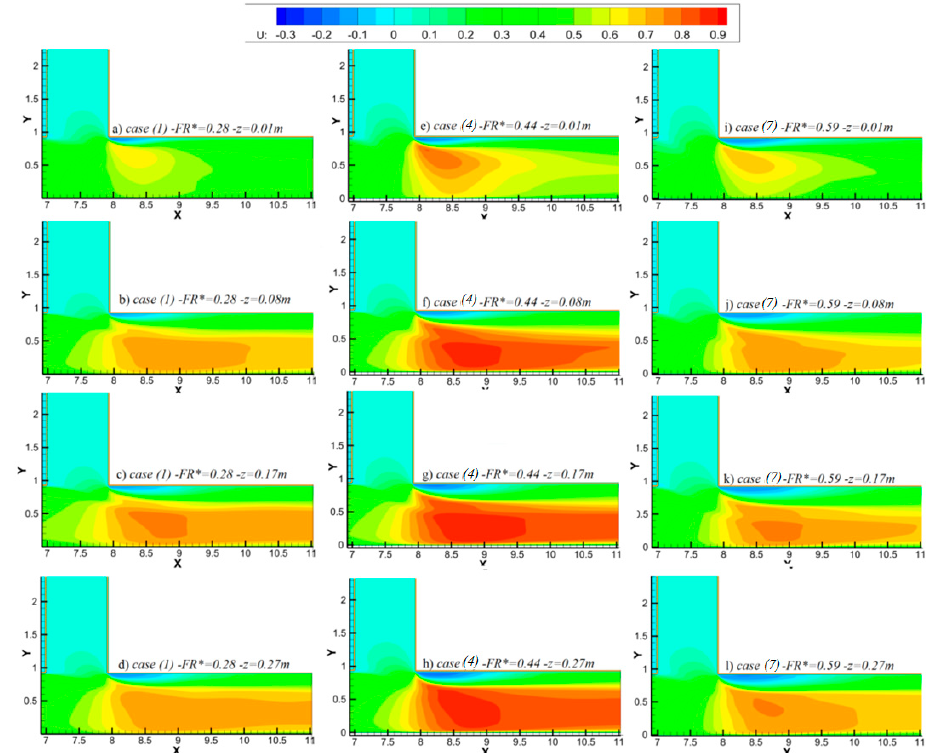
Figure 4. The distribution of the stream-wise component of velocity (U) for ( a – d ) case 1, and ( e – h ) case 4, and ( i – l ) case 7.